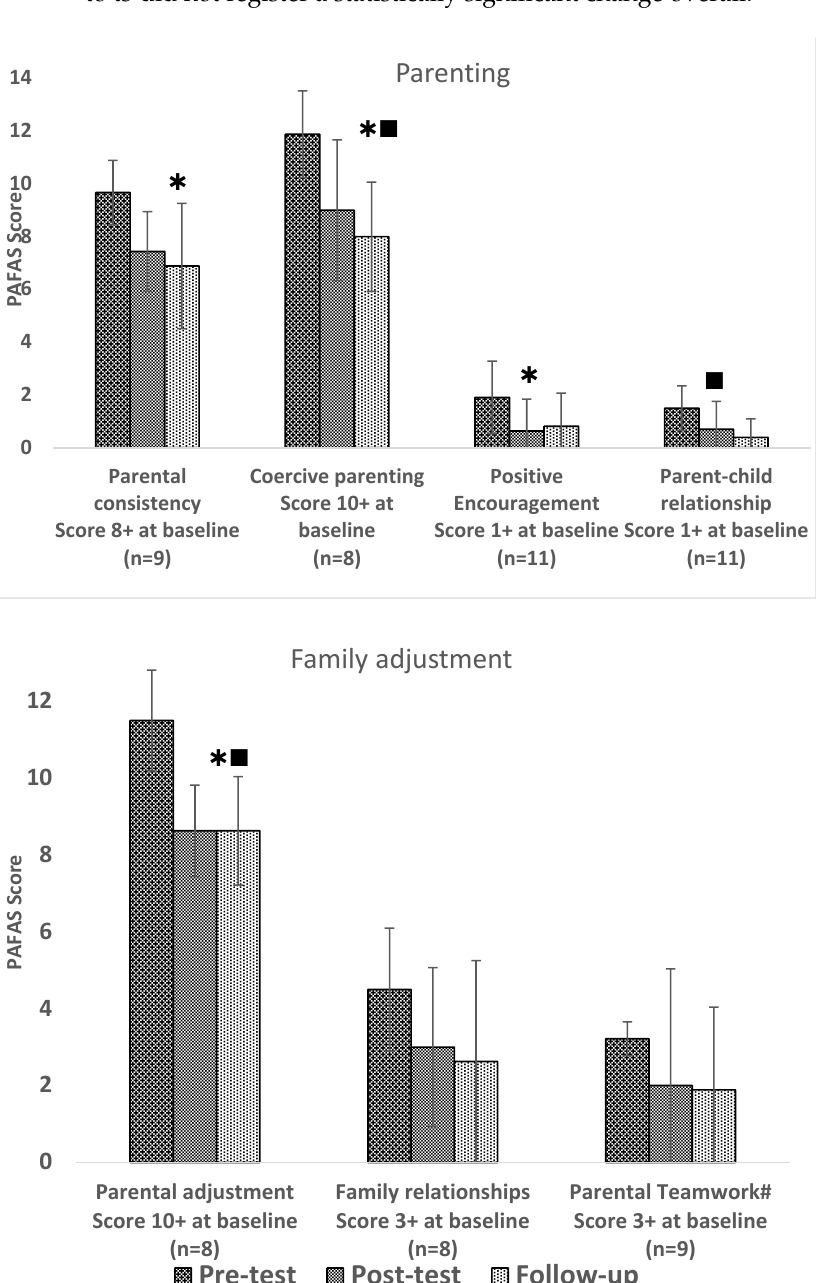
Figure 1. Number of families ( n ) and mean scores (and SD) of families scoring above the 70th percentile on each of the subscales of the Parenting and Family Adjustment Scale (PAFAS) at baseline (Pre-test; t1). Follow up two weeks (Post-test; t2) and six weeks (Follow-up; t3) after the intervention. # Scores on parental teamwork only included in analysis if in a relationship (1 divorced/separated and 2 widows excluded); If statistically significant in one-way repeated measures ANOVA, post-hoc-test results displayed as significant difference between t1 and t2, significant difference between t1 and t3.